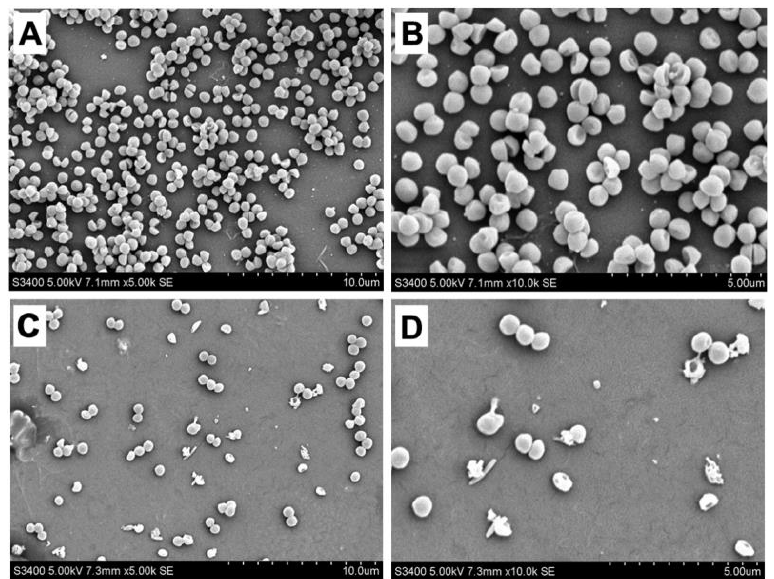
Figure 3. Morphology of MRSA (USA 300) under scanning electron microscopy. ( A , B ) show the morphology of USA 300 strain in normal culture at 5000 and 10,000 times magnification, respectively. ( C , D ) show the morphology of USA 300 strain treated with 8 µg/mL TD4 at 5000 and 10,000 times magnification, respectively.